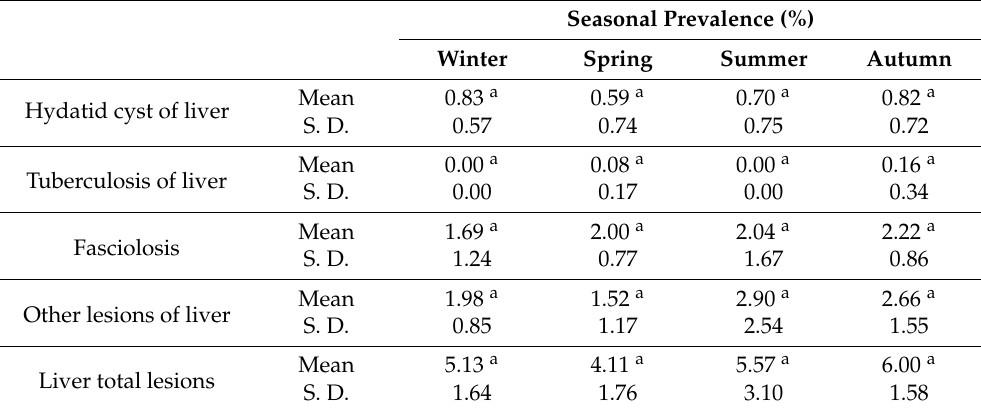
Table 2. Comparative distribution of liver lesions prevalence over seasons.